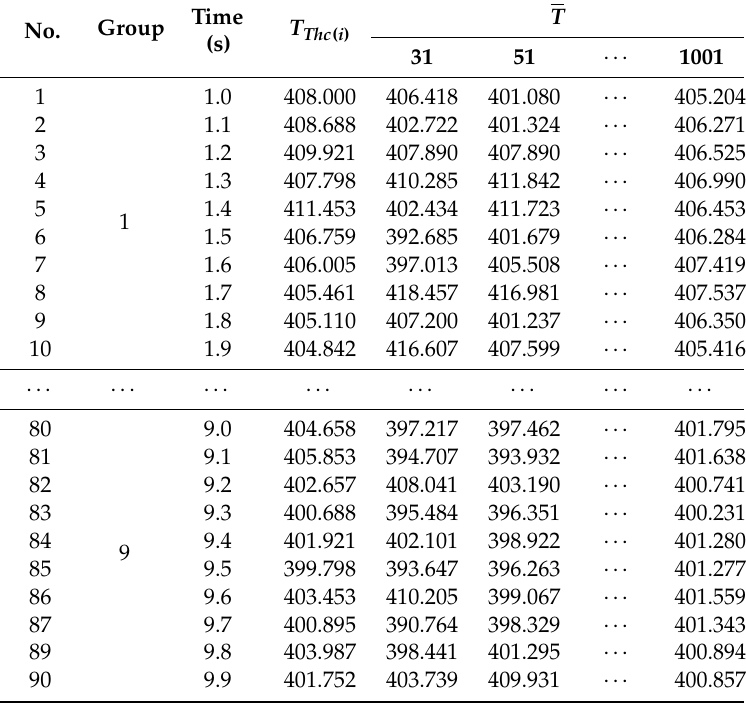
Table 3. Temperatures used in [Step